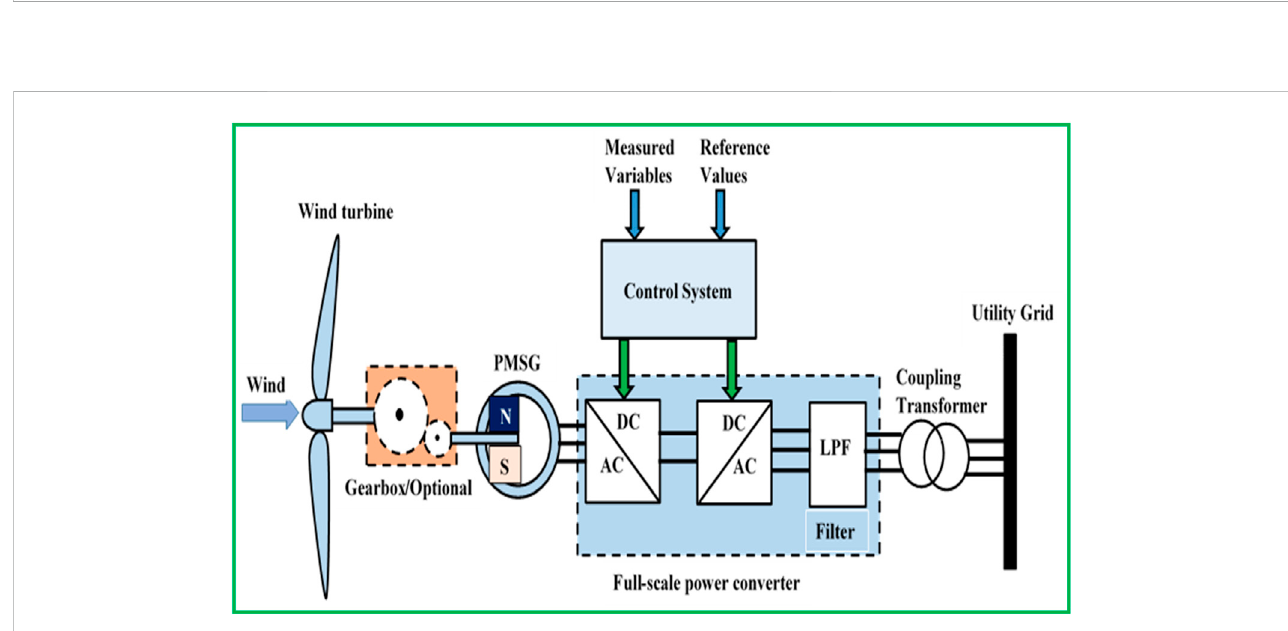
FIGURE 4 Topology of PMSG-based wind energy conversion